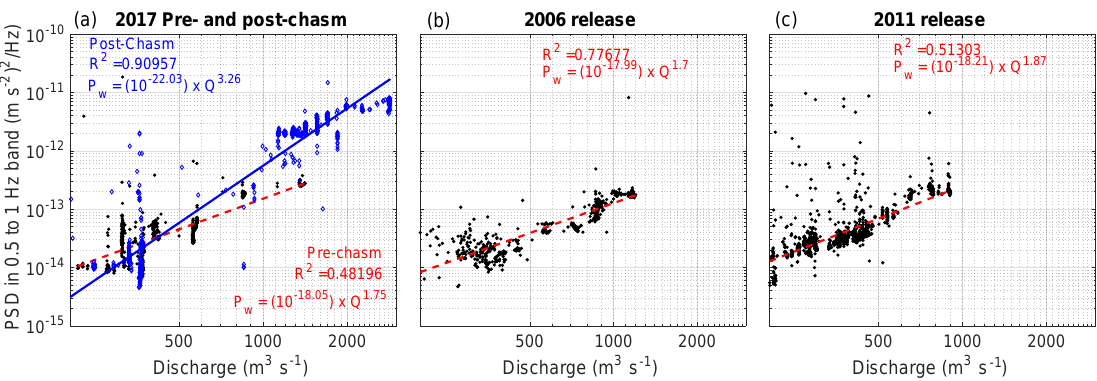
Figure 6. Analysis of the relationship between mean dominant eigenvector power and discharge for the 2017 Oroville Dam crisis and two previous flood control release events is shown in panels (a–c) . The discharge of each interval is shown in Fig. 5d. The scaling exponent of seismic power with discharge before the flood control spillway erosion, Q 1 . 75 , is more similar to the scaling observed with two prior release events with Q 1 . 70 and Q 1 . 87 in 2006 and 2011, respectively, as compared to a power scaling of Q 3 . 26 following the development of the chasm from